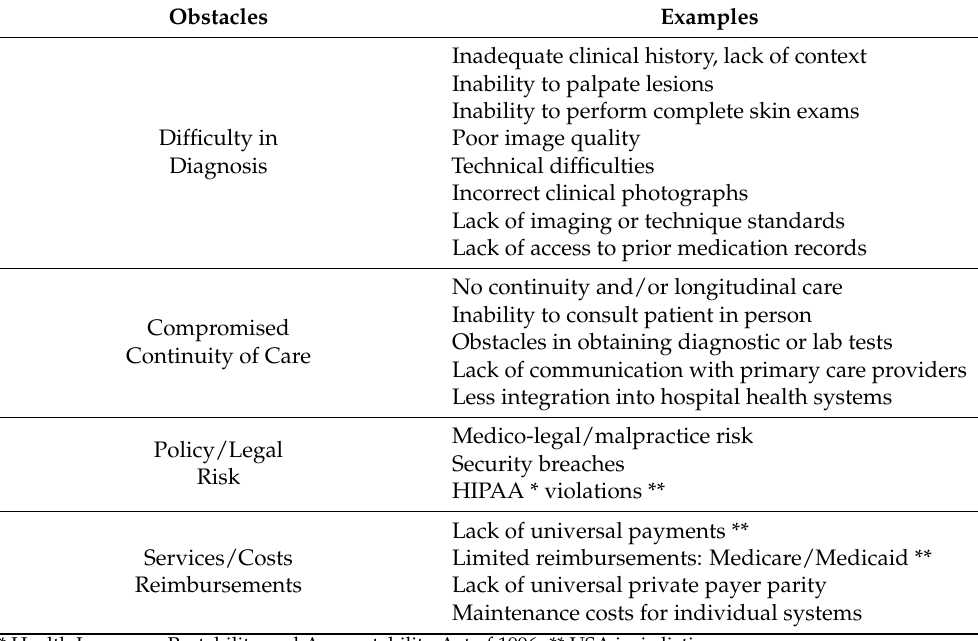
Table 5. Obstacles in Teledermatology